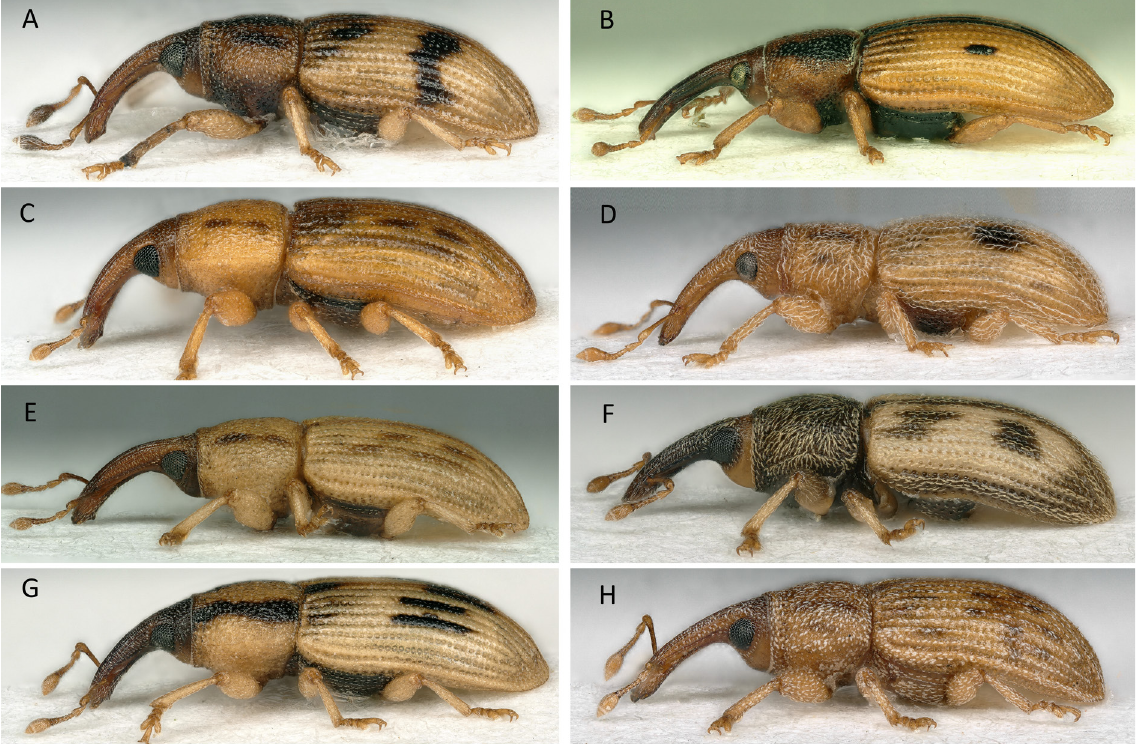
Fig. 5. A–H . Habitus of males of Ebenacobius Haran gen. nov. in lateral view (part 2). A . E.